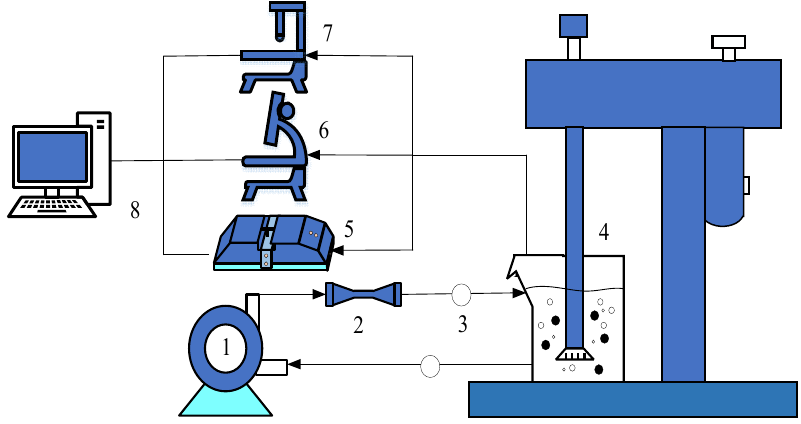
Figure 2. Schematic diagram of the experimental apparatus: ( 1 ) pump; ( 2 ) venturi tube; ( 3 ) valve; ( 4 ) flotation machine; ( 5 ) laser particle size analyzer; (6) microscope; ( 7 ) contact angle meter; ( 8 ) computer.